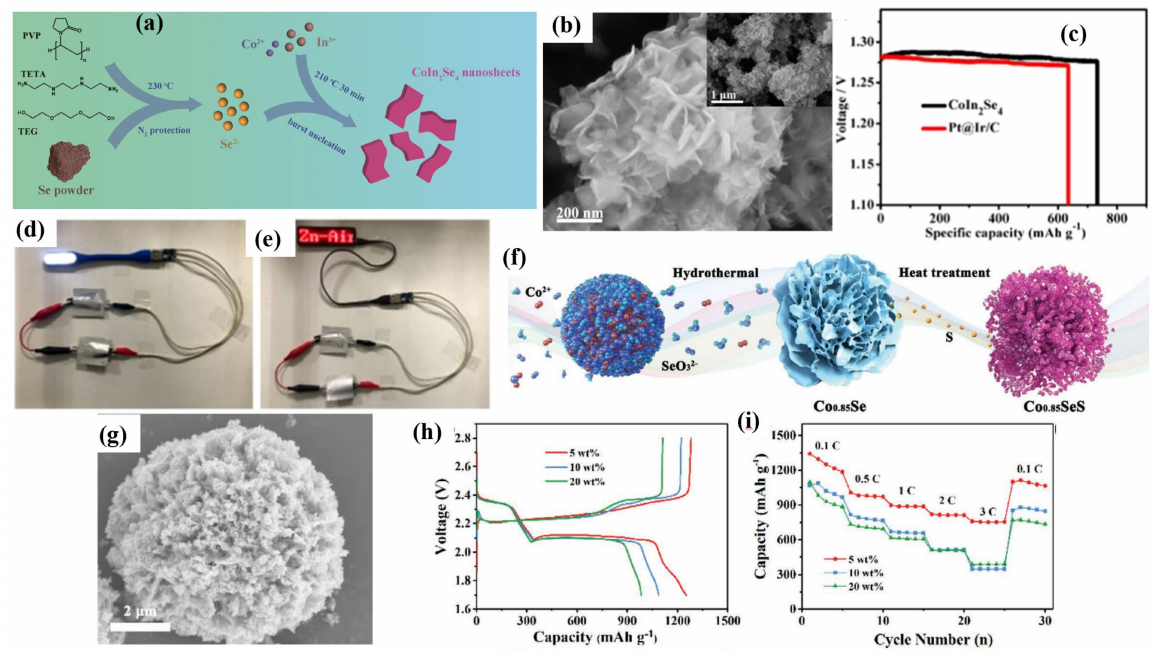
Figure 23. ( a ) Preparation process of CoIn 2 Se 4 ternary spinel selenide. ( b ) SEM image of CoIn 2 Se 4 nanosheets. ( c ) Specific capacities of Pt/C- and CoIn 2 Se 4 -based FZABs. ( d , e ) Photographs of LED lamps powered by the two-series-connected FZABs. Adapted with permission [372]. Copyright (2020) American Chemical Society. ( f ) Schematics for the synthesis, and ( g ) SEM image of Co 0.85 SeS. ( h ) Charge/discharge curves of Li–S cells cathodes at 0.1 C with different amounts of Co 0.85